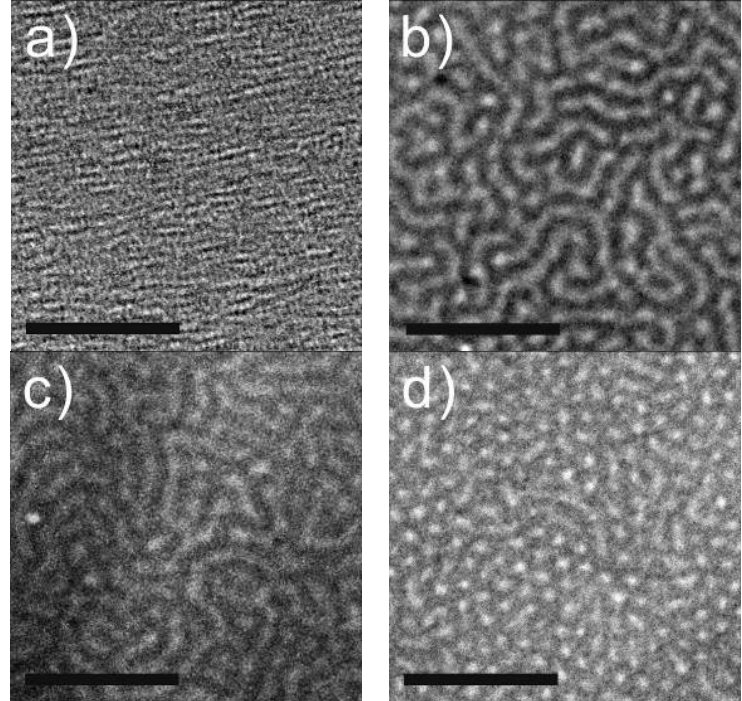
Figure 4. The bright-field TEM images of the membranes. ( a ) PS- b -PEO (unannealed); ( b ) PS- b -PEO (annealed); ( c ) PS- b -PEO/M0.5 (annealed); and ( d ) PS- b -PEO/M1 (annealed) (scale bar: 200